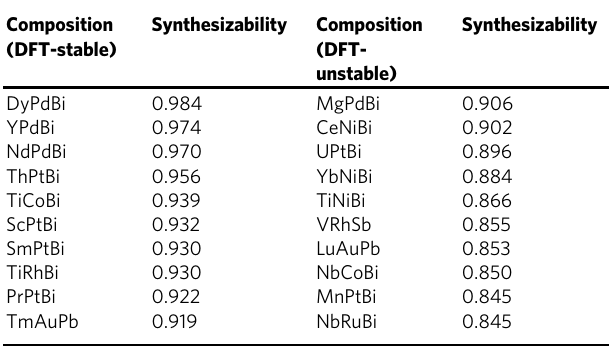
Table 3 Top potential candidates for future